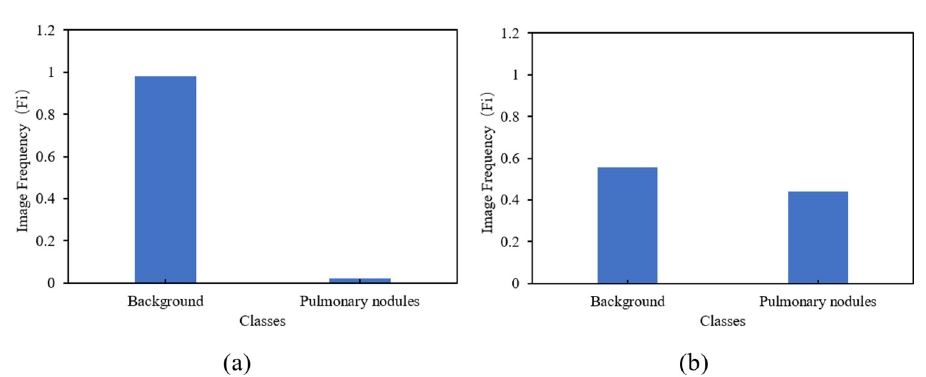
Fig 7. Pixel distribution of (a) original images and (b) after class weighting for the LUNA16 dataset.